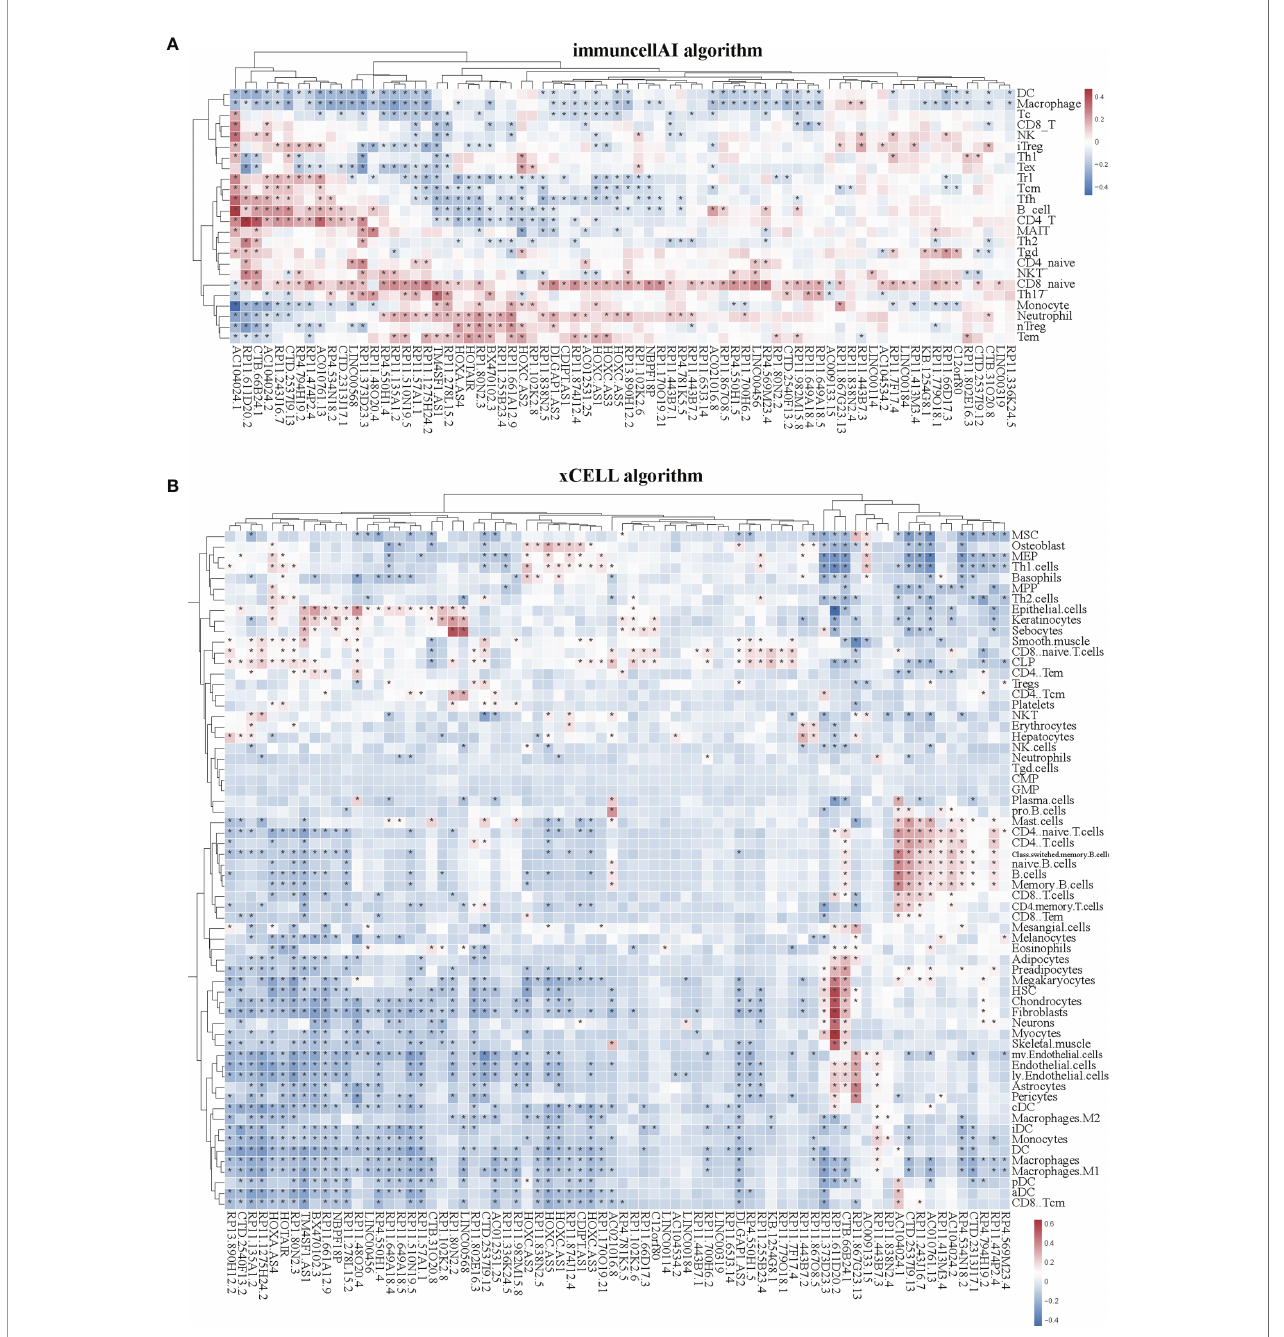
FIGURE 3 | Correlation between the expression of super-enhancer-associated lncRNA and immune cell in fi ltration in patients with STAD. (A) Cluster analysis of the correlation between 74 SE-associated lncRNAs expression and immune cells abundance calculated by using the ImmuCellAI algorithm. (B) Cluster analysis of the correlation between 74 SE-associated lncRNAs and immune cells abundance calculated with the Xcell algorithm. Red indicates positive correlation, while blue indicates negative correlation. The asterisk (*) signi fi es a signi fi cant correlation p < 0.05. The expression of 74 SE-associated lncRNAs were downloaded from TCGA database (https://www.cancer.gov/). Immune cell in fi ltration was calculated by using the ImmuCellAI (http://bioinfo.life.hust.edu.cn/ImmuCellAI/#!/) and Xcell algorithm (https://xcell.ucsf.edu/) in